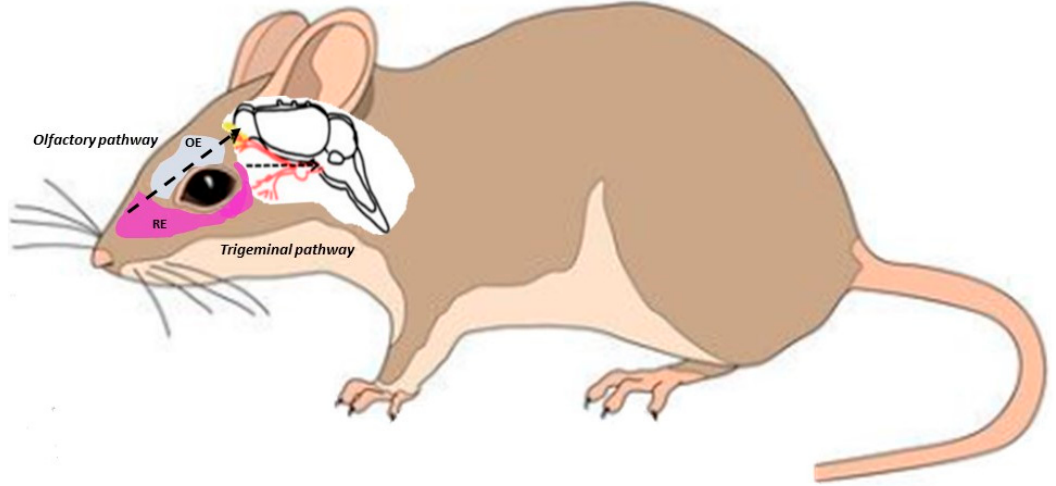
Figure 4. Intranasal pathways for brain absorption of